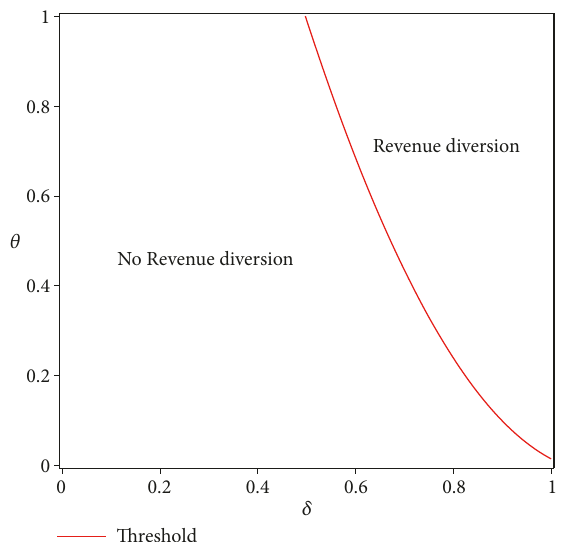
Figure 6: Conditional existence of revenue